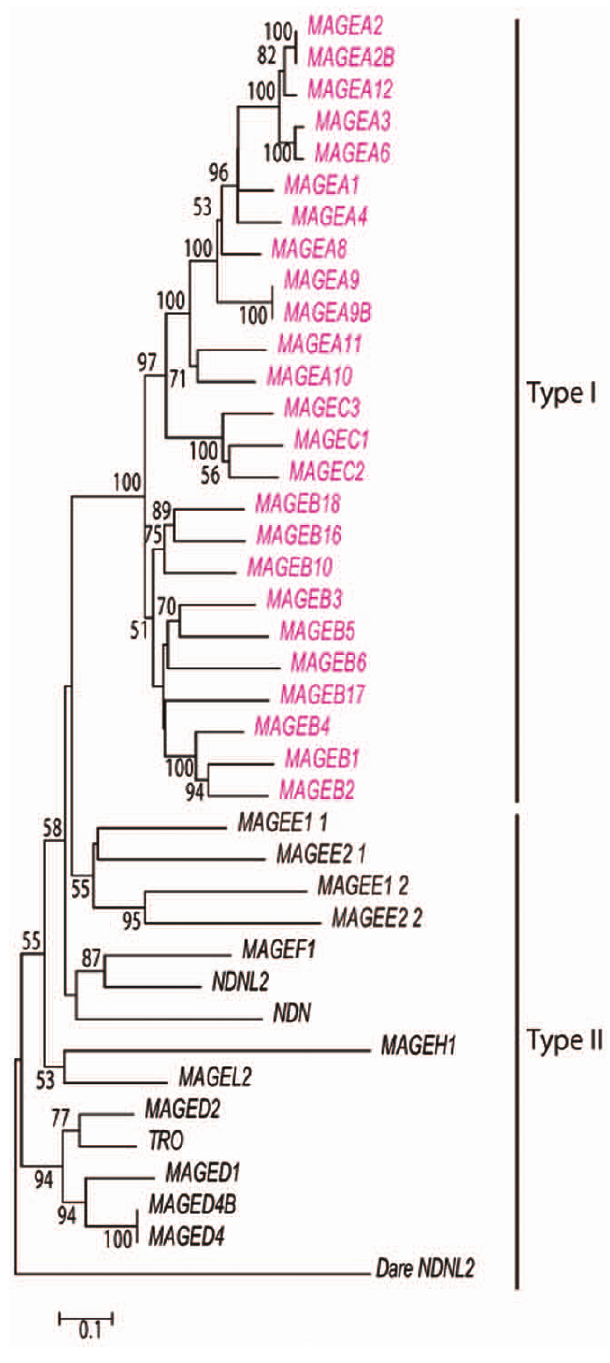
Figure 3. Phylogeny of MHD in human MAGE genes. The tree is based on the number of amino acid differences per site ( p -distances). Genes but for DareNDNL2 in the tree are all MAGE genes found in the human genome. DareNDNL2 from zebrafish is used to determine the root of the tree. The number of sites compared is 92 amino acids without gaps. The bootstrap value is indicated at the node. Sequences are listed in Table S1. MAGE-E has duplicated MHD and the duplication has occurred earlier than the emergence of type I genes. MAGEE1_1 ( MAGEE2_1 ) and MAGEE1_2 ( MAGEE2_2 ) represent the MHD at the N and C terminal side of MAGE-E1 ( MAGE-E2 ), respectively. The eutherian MAGE-D3 gene encodes trophinin (TRO), which is expressed in the placenta and affects embryo implantation.